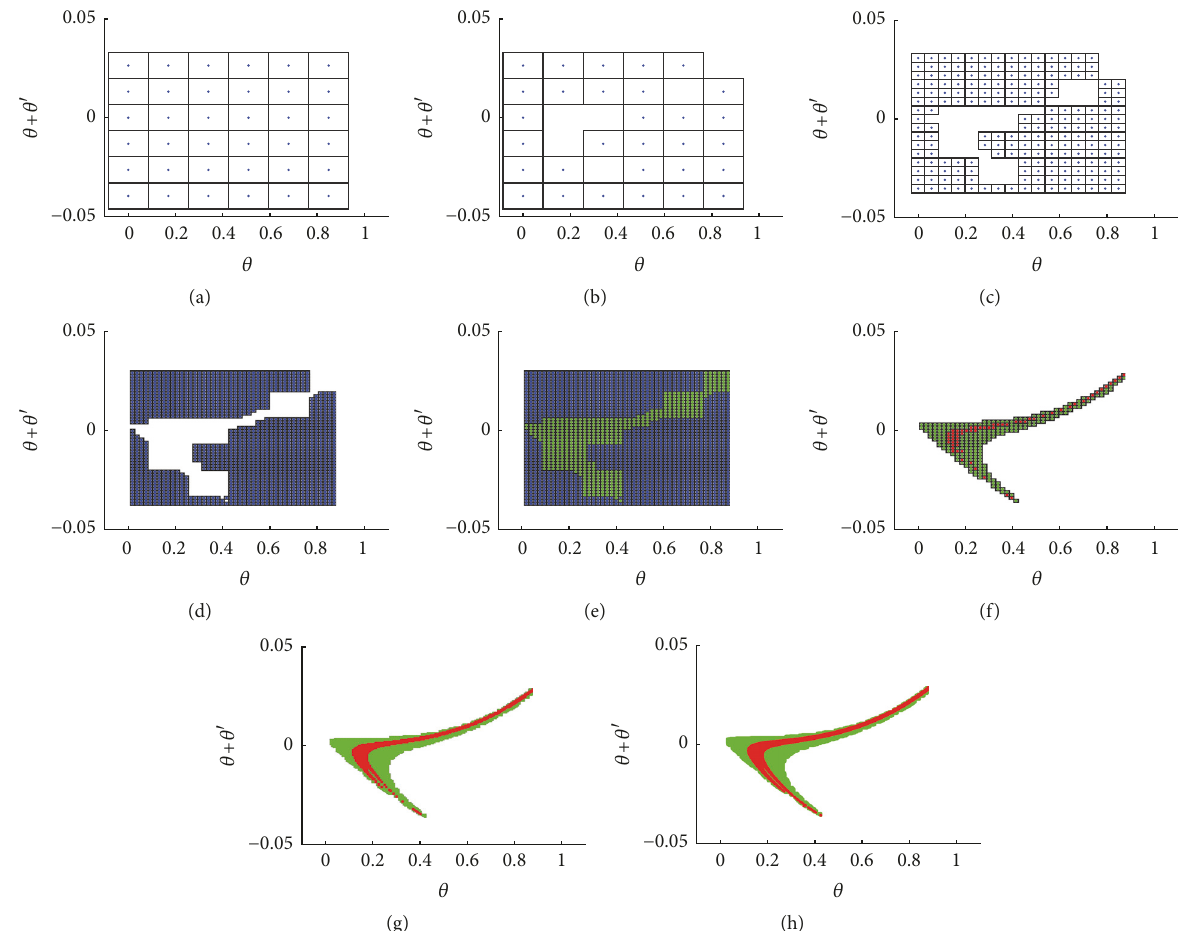
Figure 4: The processes of estimating the DOA of SPBW by the MICM method. (a) Initial discretization of DOI; (b) initial DOF; (c) DOF after the first iteration of the cell delete procedure; (d) stable DOF; (e) approximate DOC and stable DOF; (f) initial DOA and initial DOC; (g) DOA and DOC after the first iteration of the cell refinement procedure; (h) stable DOA and its corresponding